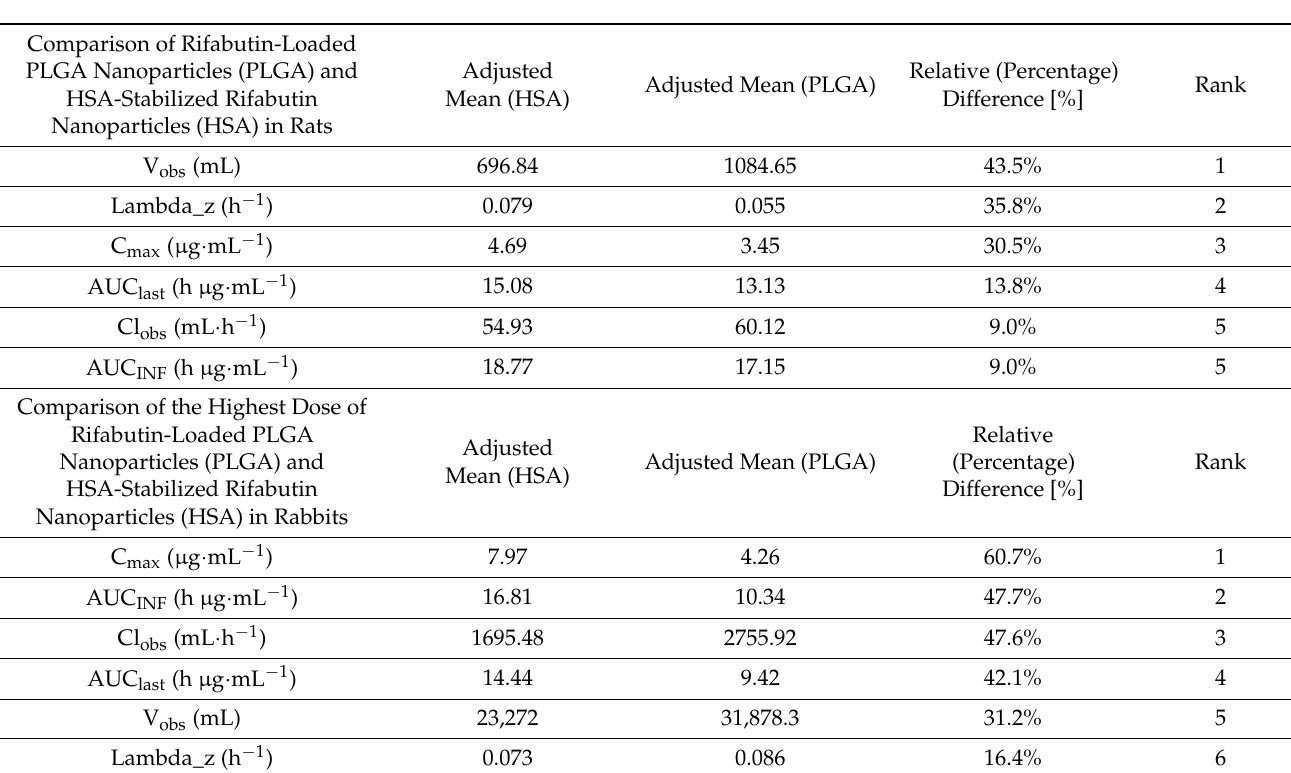
Table 2. NCA evaluation of the pharmacokinetics of HSA-stabilized rifabutin nanoparticles and rifabutin-loaded PLGA nanoparticles in rats ( n = 6 for the HSA and PLGA groups) and rabbits ( n = 6 for the HSA group and n = 5 for the PLGA group) at the lowest dose strength using the PKanalix bioequivalence module. The parameters have been ranked by the relative difference between the two formulation